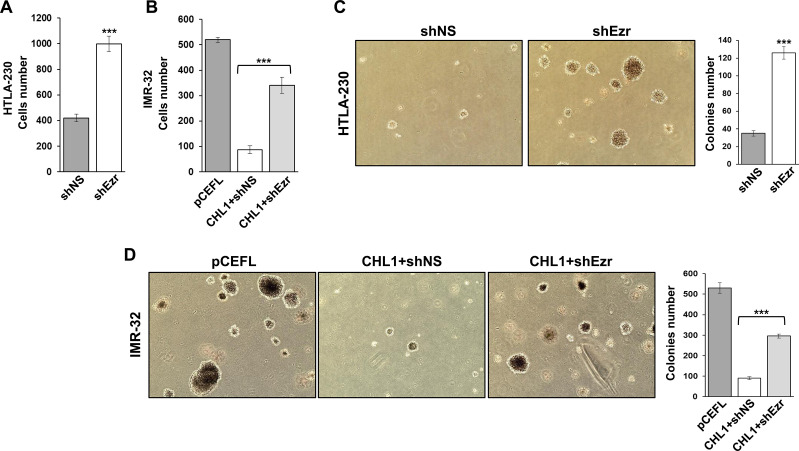
Ezrin down-regulation in NB cells increases migration and anchorage-independent growth.A migration assay was conducted for (A) HTLA-230 cells transfected with shNS or shEzr and for (B) IMR-32 cells transfected with pCEFL or cotransfected with pCEFL-CHL1 and shNS or shEzr. Cells were seeded 48 hours after transfection in the upper chamber of a Transwell insert: the ones which migrated to the lower side 24 hours later were detached and counted. (Three independent experiments ± S.D). (C) Colonies formed by HTLA-230 cells transfected with shNS or shEzr and by (D) IMR-32 cells transfected with pCEFL or cotransfected with pCEFL-CHL1 and shNS or shEzr. Cells were collected 48 hours after transfection and cultured in soft agar for 10 days. (Magnification 4x). Histograms show the mean colony number from three independent experiments ± S.D. (***p < 0.001).